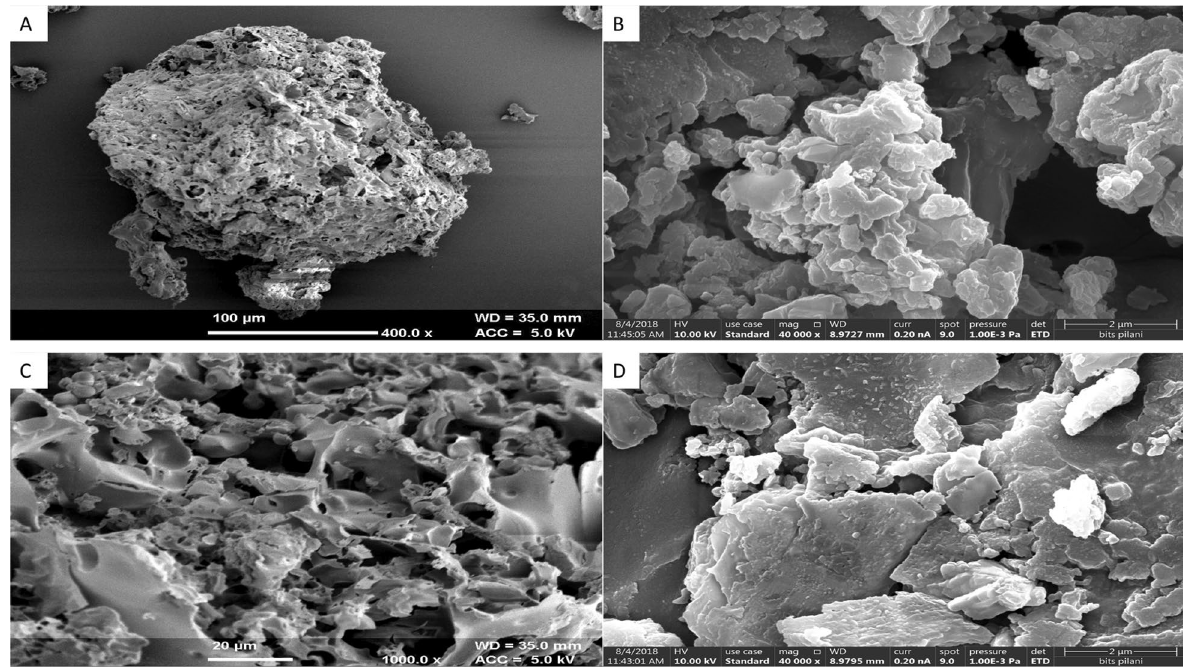
Fig. 8 SEM images of blank nanosponges, NS4 ( A , C ) and dithranol-loaded nanosponges, DTLNS4 ( B , D